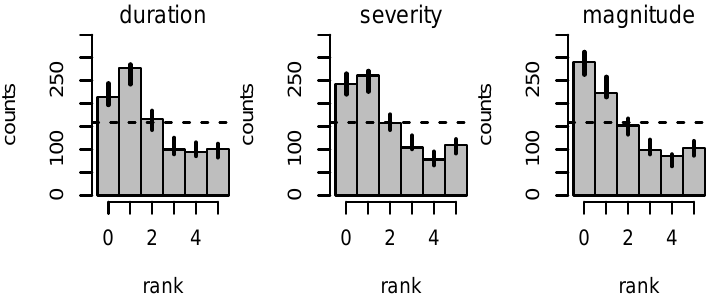
Fig. 9. Rank histograms with 90% confidence intervals of forecast duration, severity and magnitude. The histogram shows the number of observations attributed to each rank, i.e., the number of times observations lie within the 6 classes formed by the 5-member ensemble forecast. A well-calibrated ensemble prediction system would match the dashed line.